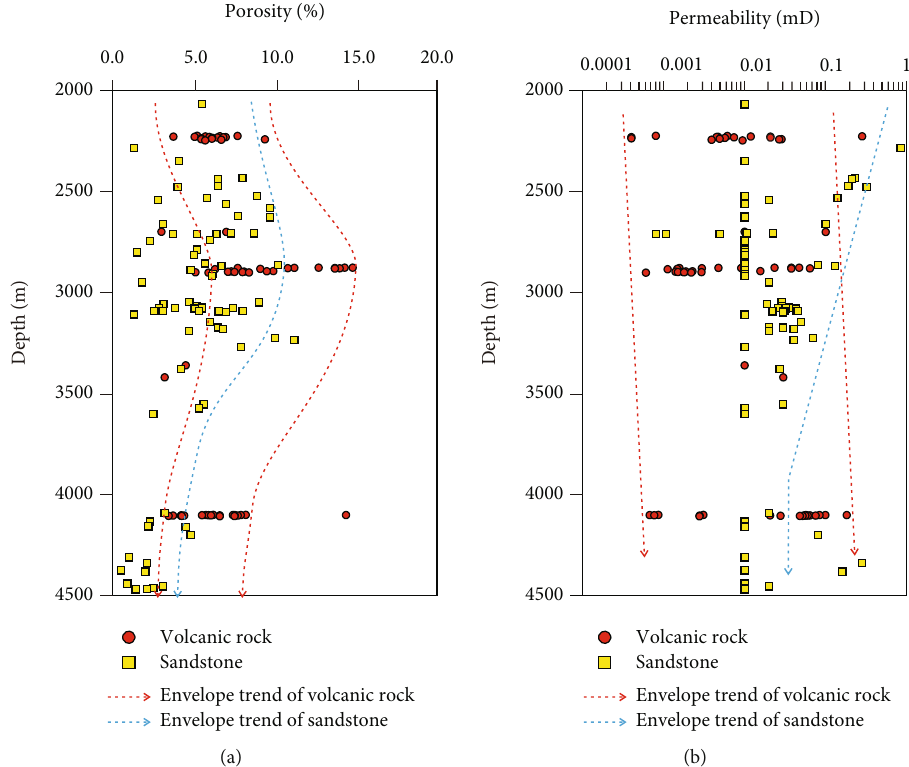
Figure 12: (a) Porosity and (b) permeability versus the depth of volcanic rock reservoir and tight sandstone reservoir samples for the K